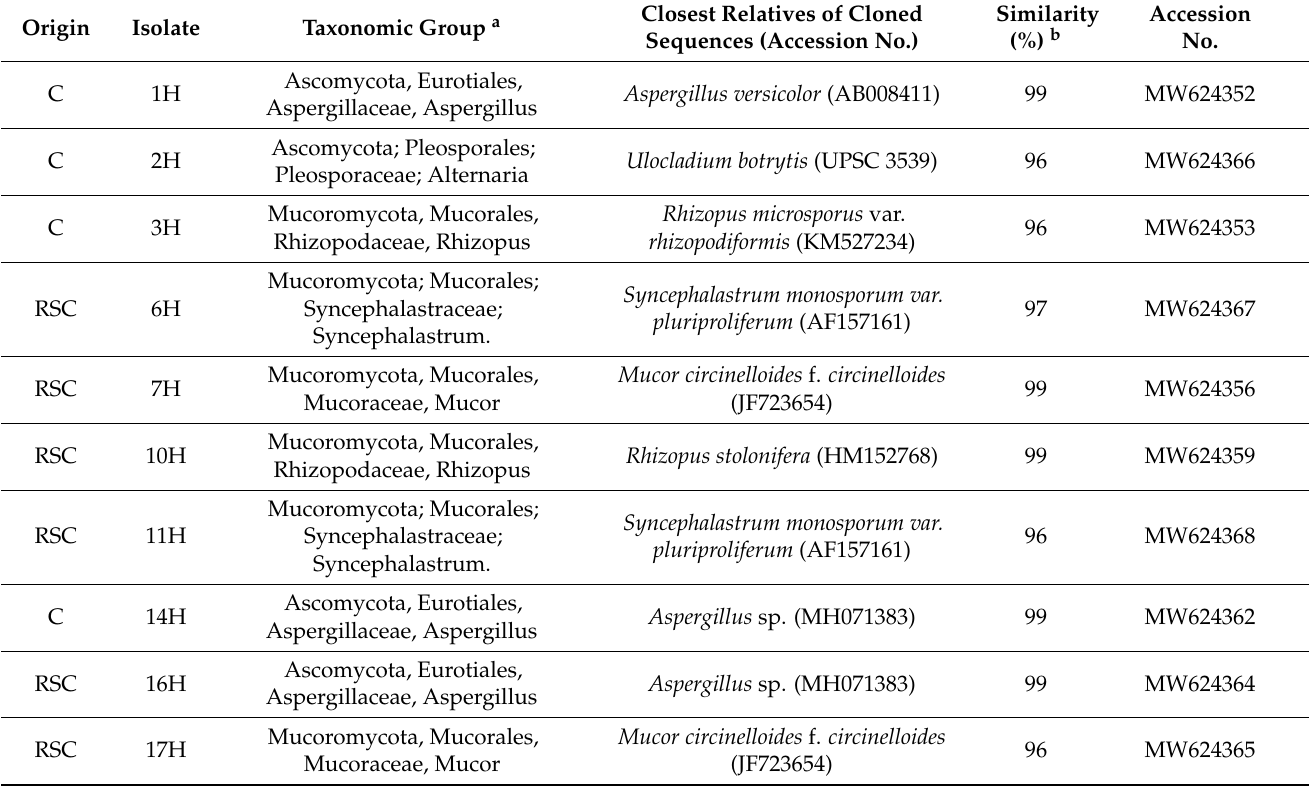
Table 2. Taxonomic assignment of fungal isolates with hyphae-associated bacteria using fungal highway column system (FHCS) selection and isolation approach. C and RSC refer to compost and rhizosphere soil with compost application,